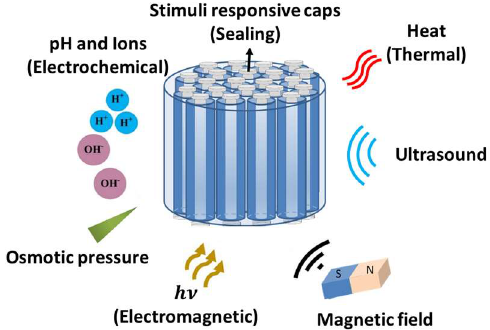
Figure 6. Different types of sealing strategies used for stimuli-responsive MSNs.